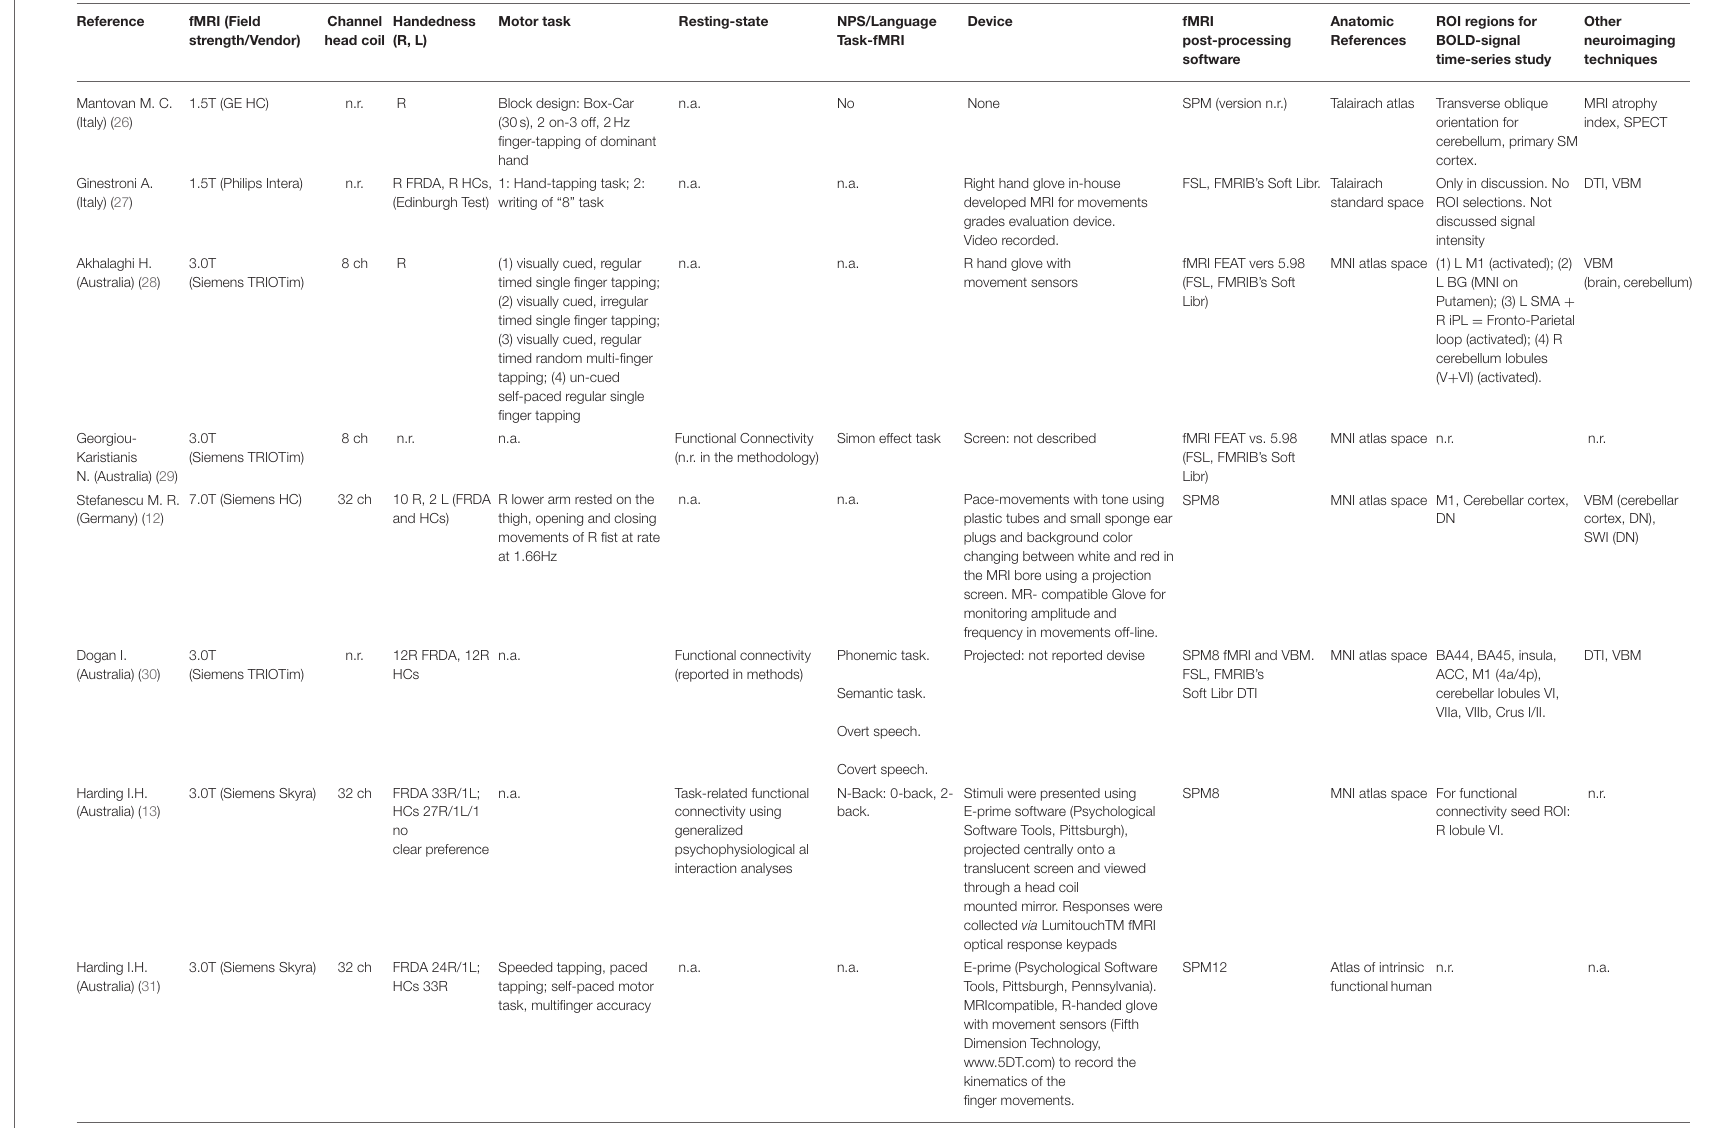
TABLE 2 | fMRI paradigm.